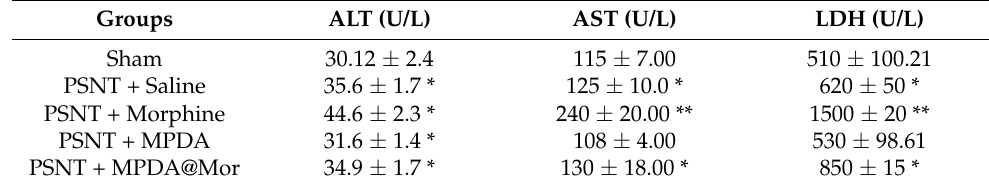
Table 3. Effects of morphine, MPDA@Mor on liver enzyme functions in sham and PSNT rats.